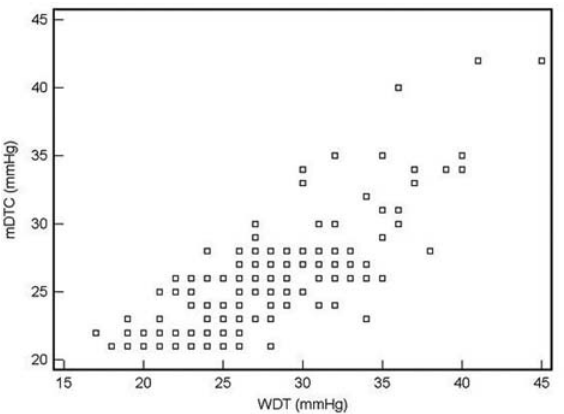
Figure 2 - Correlation between IOP peaks during the WDT and